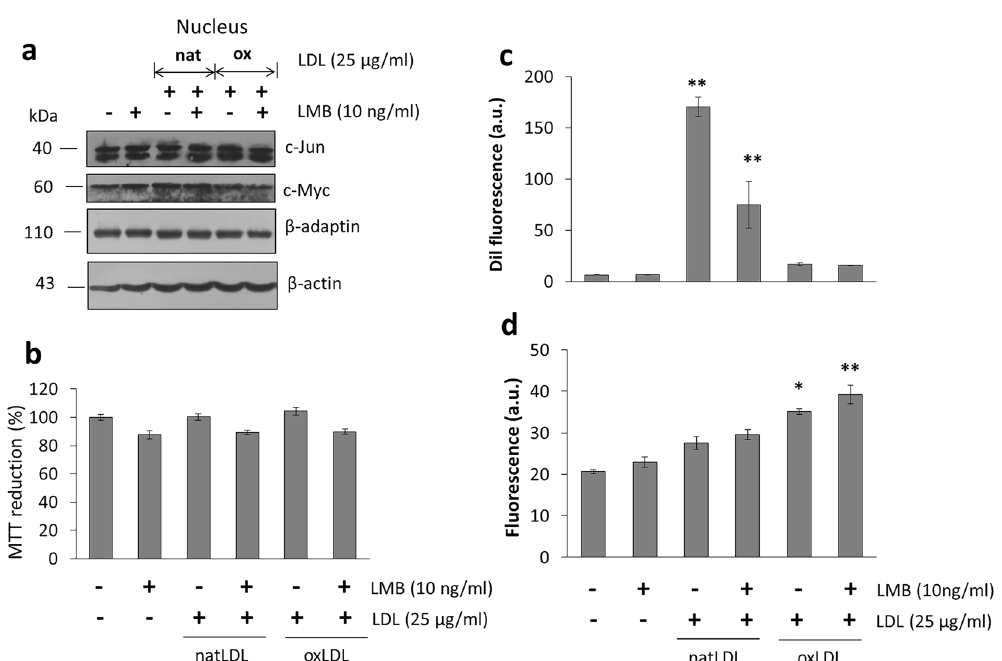
Figure 9. A prolonged LMB treatment (16 h) in hepG2 cells induces a state of severe oxidative stress. ( a ) Western blot analysis in the expression of proteins c-Jun, c-Myc and β -adaptin present in the nuclear fraction after a prolonged LMB treatment in the presence of natLDL and oxLDL. ( b ) Under the same conditions, cell viability obtained by MTT assays. ( c ) LMB effect upon internalization of dil-fluorescently labeled natLDL and oxLDL. ( d ) ROS characterization under the same conditions. Mean values are presented (n = 6, X ± SD) * p < 0.05, ** p <